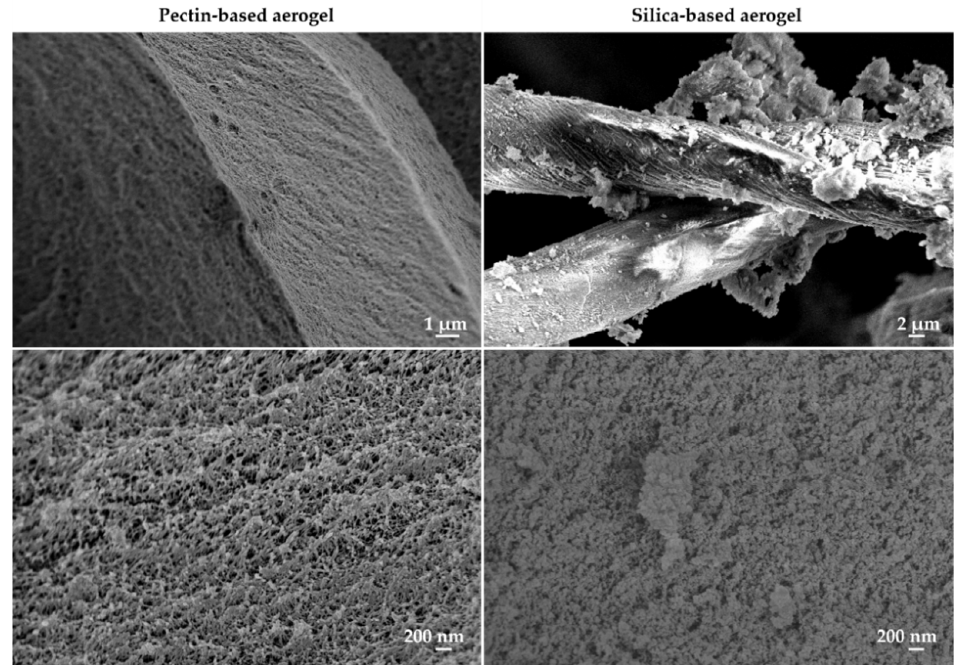
Figure 3. Scanning electron microscopy (SEM) images of pectin ‐ based ( left images) and silica ‐ based ( right images) aerogels at different magnifications.